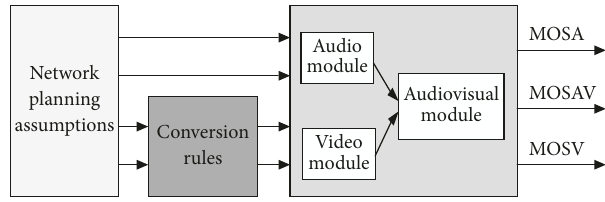
Figure 18: Overall G.1071 model